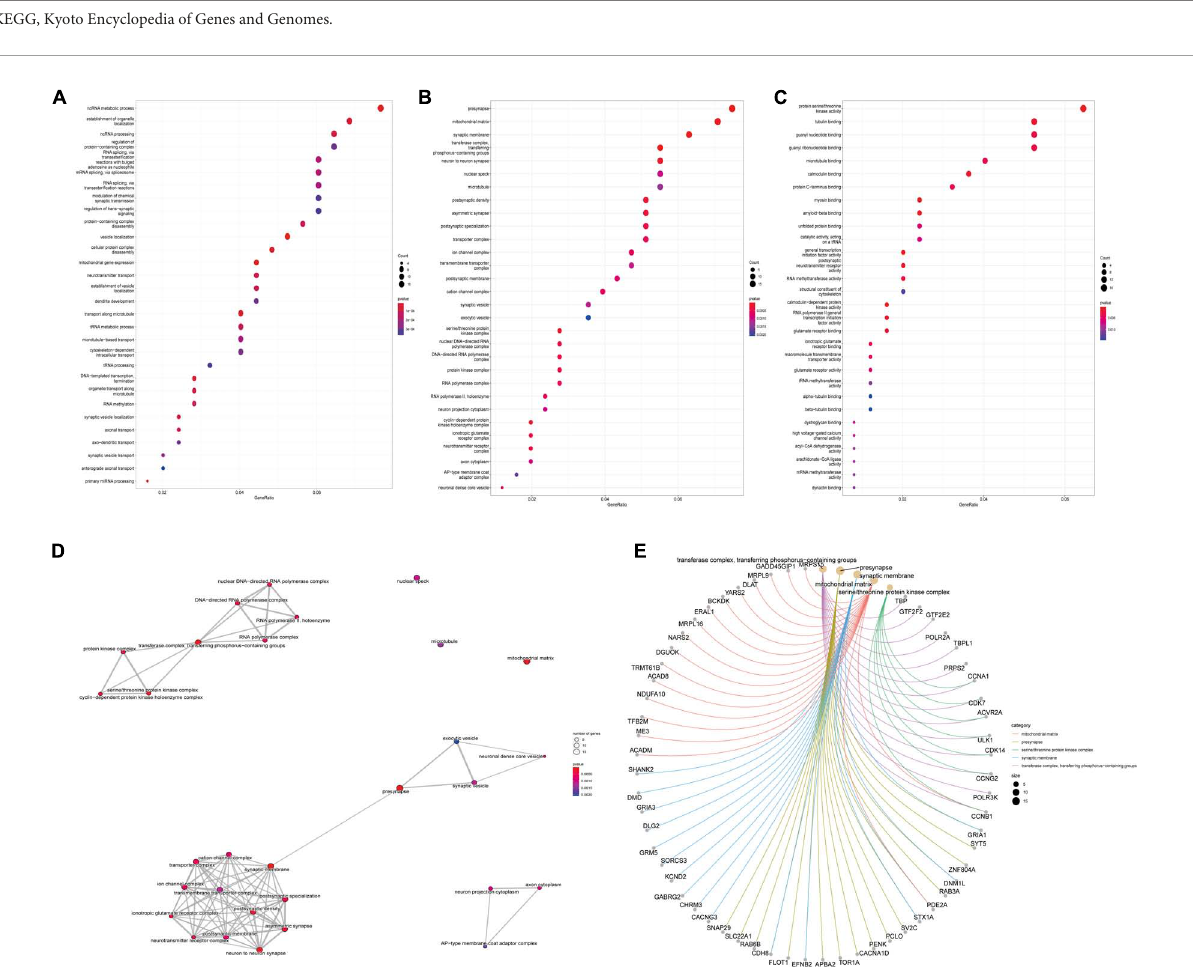
FIGURE3 Differentially expressed gene’s (DEG’s) GO analysis. (A) GO bioprocess enrichment. (B) Cell composition enrichment results. (C) Results of molecular function enrichment. The color of each bubble represents the fitted p -value: the redder the color, the higher the concentration. (D) The relationship between the classes. (E) The genes contained in the more enriched category. GO, Gene Ontology.